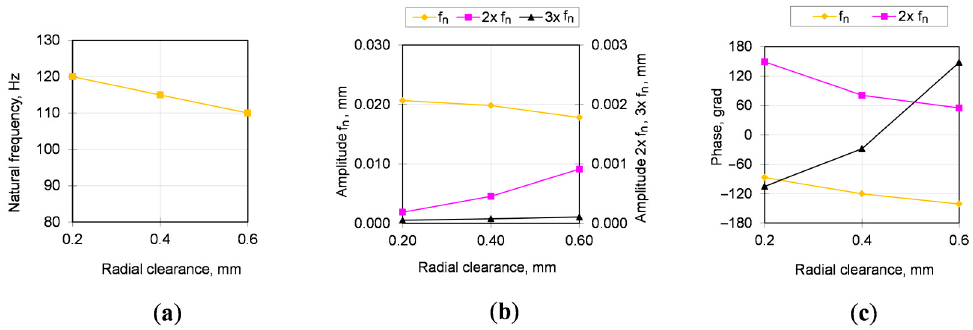
Figure 8. Natural frequency ( a ), amplitudes ( b ) and phases ( c ) of harmonics during transient vibrations of gearbox shaft without the bolted joint opening. Table 2. Results of vibration measurements (Figure